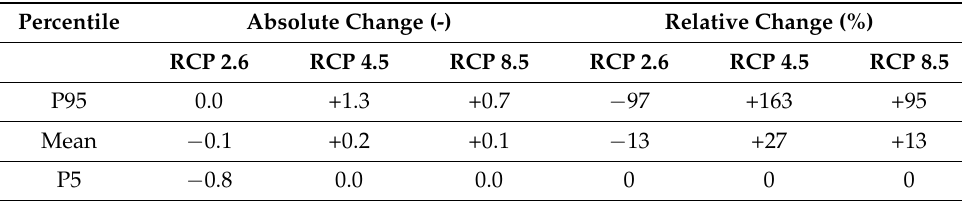
Table 5. Statistics on the absolute change in the yearly mean M in uninsulated walls for RCPs 2.6, 4.5 and 8.5 and SW